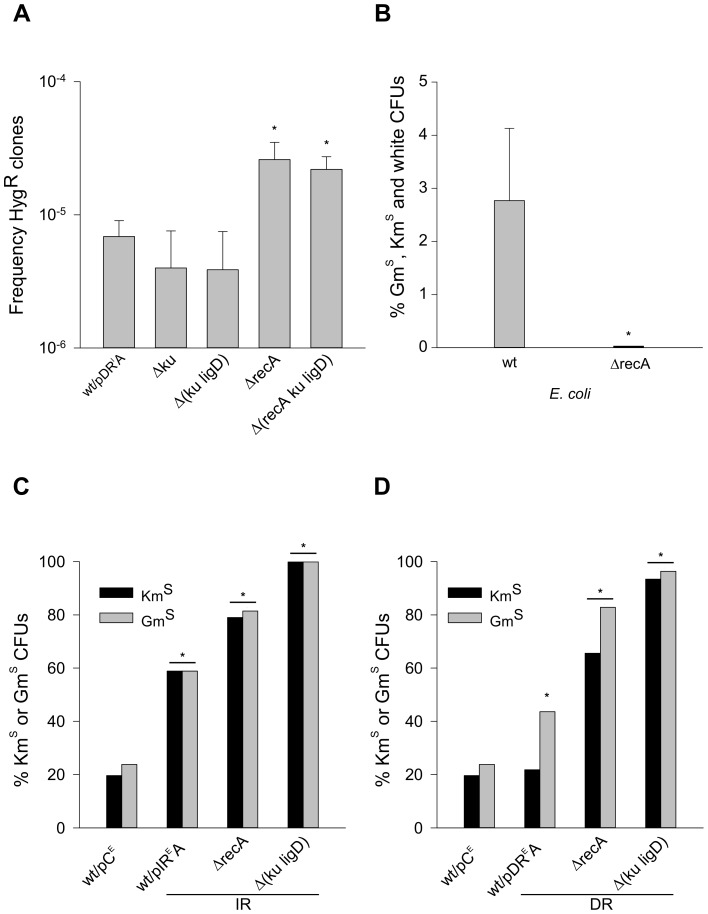
Deletions occur independently of NHEJ and HR in M. smegmatis.
Panel A, precise deletions stimulated by DRs occur independently of NHEJ and are increased in the absence of RecA. x-axis, M. smegmatis strains: wt/pDRIA, wild-type/pMV306KmHyg::OligoDRGmA
lacZ; Δku, Δku/pDRIA; Δ(ku ligD), ΔkuΔligD/pDRIA; ΔrecA, ΔrecA/pDRIA; Δ(recA ku ligD), ΔrecAΔkuΔligD/pDRIA; y-axis, frequencies of HygR CFUs; asterisks, p<0.05 (pair-wise Holm-Sidak test for mutant strains against wild-type). Panel B, large deletions are stimulated by HR (RecA) in E. coli. x-axis, E. coli strains carrying the self-replicating OligoIR vector pIREA; wt, KMBL1001; ΔrecA, Top10 mutant; asterisks, p<0.05 (χ2 test of mutant strains against wild-type). Panels C and D, large deletions occur independently of NHEJ and HR in M. smegmatis. x axis, M. smegmatis strains; y-axis, percent KmS (black bars) or GmS (grey bars) CFUs. Panel C, M. smegmatis strains: wt/pCE, wild-type/pMV206KmHyg::Gm (control); wt/pIREA, wild-type/pMV206KmHyg::OligoIRGmA
lacZ; Δ(ku ligD), ΔkuΔligD/pIREA; ΔrecA, ΔrecA/pIREA. Panel D, M. smegmatis strains: wt/pCE, as in Panel D; wt/pDREA, wild-type/pMV306KmHyg::OligoDRGmA
lacZ; Δ(ku ligD), ΔkuΔligD/pDREA; ΔrecA, ΔrecA/pDREA (asterisks, p<0.05 (χ2 test of mutant strains against wild-type).